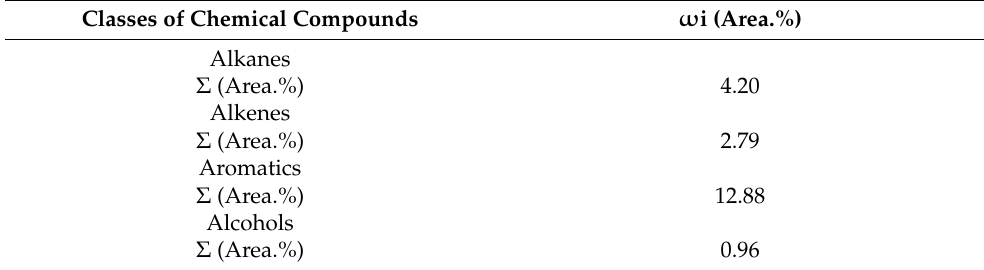
Table 12. Classes of compounds and summation of peak areas of hydrocarbons and oxygenates identified by CG-MS in kerosene-like fraction (200–215 ◦ C) after distillation of bio-oil obtained in pilot